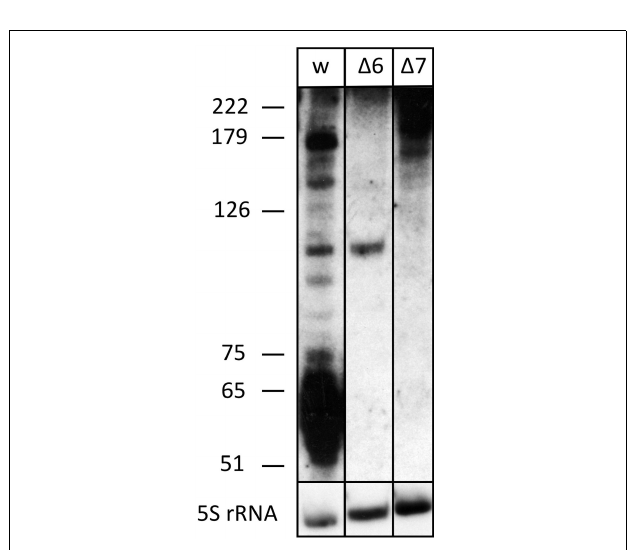
FIGURE 4 | The processed s479 species are lost upon deletion of genes for the Cas6 or Cas7 protein. Total RNA was separated on a polyacrylamide gel. After transfer, a probe against s479 was used for hybridization (upper panel). A size marker is given at the left. Lane w: RNA from H. volcanii H119 wild-type strain, lane (cid:49) 6: RNA from H. volcanii cas6 deletion strain (cid:49) cas6 , lane (cid:49) 7: RNA from H. volcanii cas7 deletion strain (cid:49) cas7 . In the lower panel, hybridization with a probe against 5S rRNA is